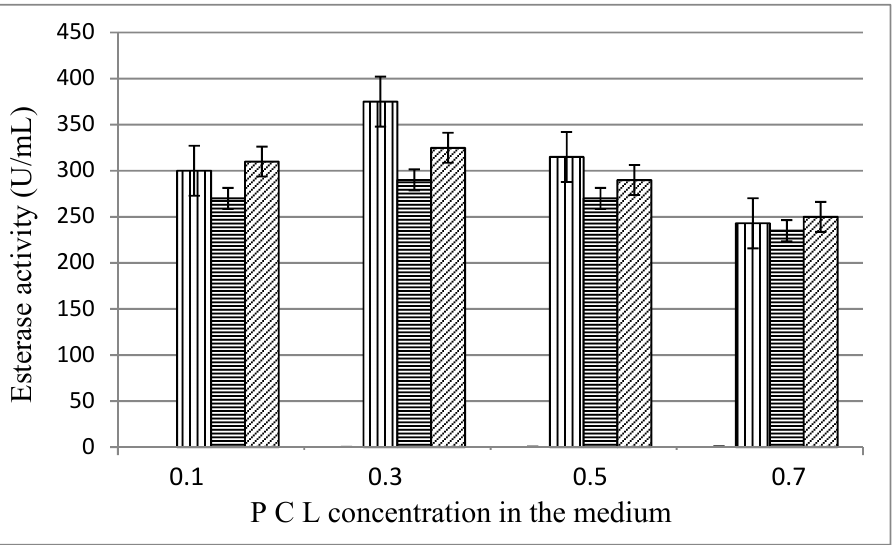
P C L concentration in the medium Figure 3. Esterase activity (48 h) in different PCL concentration in the medium; Figure 3. Esterase activity (48 h) in different PCL concentration in the medium; Figure 3. Esterase activity (48 h) in different PCL concentration in the medium; , MKC-P; , Figure 3. Esterase activity (48 h) in different PCL concentration in the medium; , MKC-P; Figure 3. Esterase activity (48 h) in different PCL concentration in the medium; , MKC-P; , B. thermoruber strain 7; , co-culture of strain 7 and A. thermoaerophilus strain 2. B. thermoruber strain 7; , co-culture of strain 7 and A. thermoaerophilus strain 2. B. thermoruber strain 7; , co-culture of strain 7 and A. thermoaerophilus strain 2. B. thermoruber strain 7; , co-culture of strain 7 and A. thermoaerophilus strain 2. , co-culture of strain 7 and A. thermoaerophilus strain